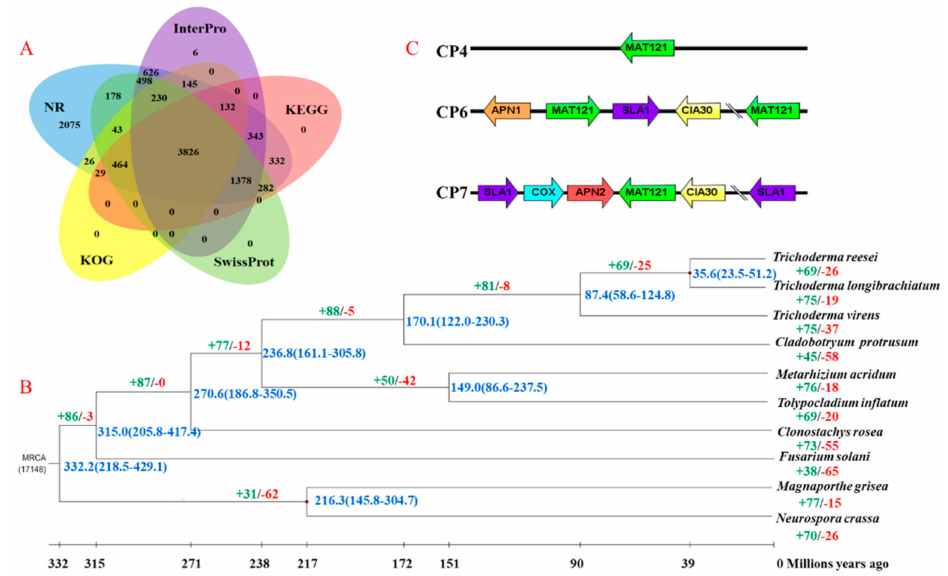
Figure 1. Annotation, phylogenetic and divergence time tree, and mating-type gene structure of the C. protrusum genome assembly. ( A ) Functional annotation of the protein-coding genes in